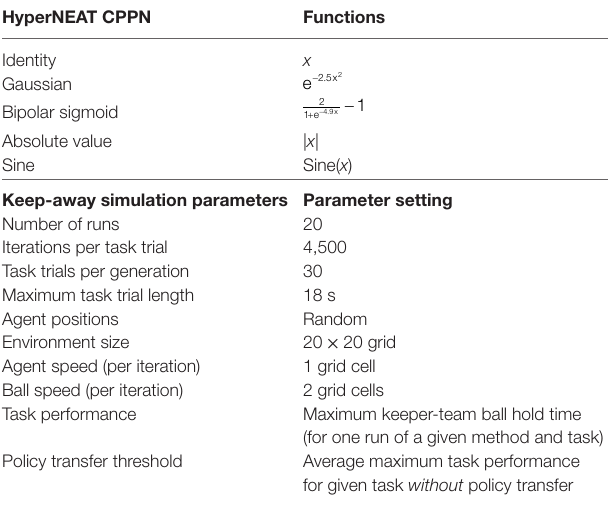
TaBle 3 | HyperNEAT CPPN functions, keep-away simulation parameters and settings.